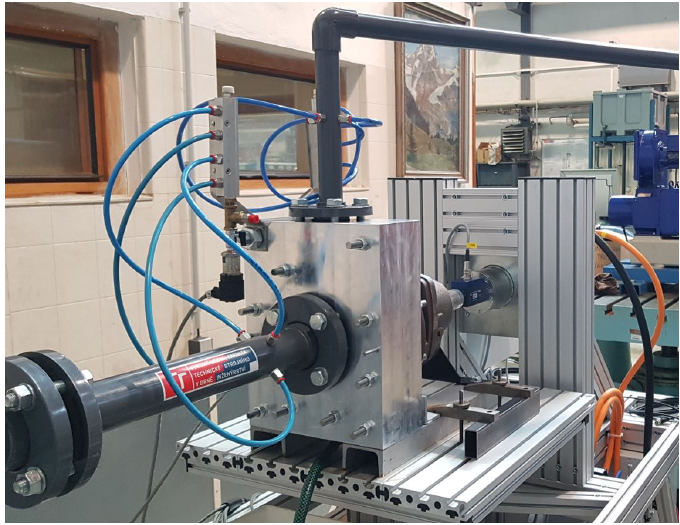
Figure 5. Schematic diagram of the test rig.